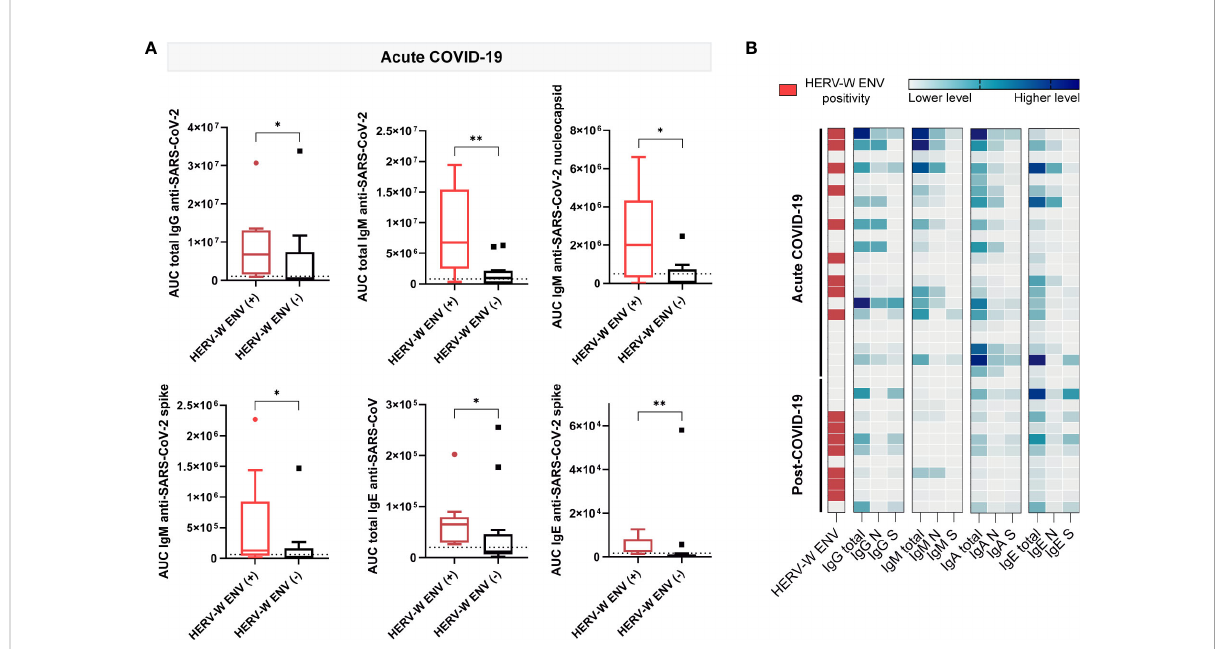
FIGURE 4 Comparison of plasma circulating anti-SARS-CoV-2 immunoglobulin levels in samples positive (+) and negative (-) for HERV-W ENV protein antigenemia. (A) Boxplots showing levels of IgG, IgM and IgE calculated as the mean of the area under the curve (AUC) according to electropherograms in positive and negative HERV-W ENV samples of acute COVID-19 patients. *p < 0.05, **p<0.01 according to Mann-Whitney Test. (B) Heatmap analysis of HERV-W ENV protein antigenemia and levels of IgG, IgM, IgA and IgE against SARS-CoV-2 nucleocapsid, spike or both (total) in acute (n=22) and post (n=12) COVID-19 cases.